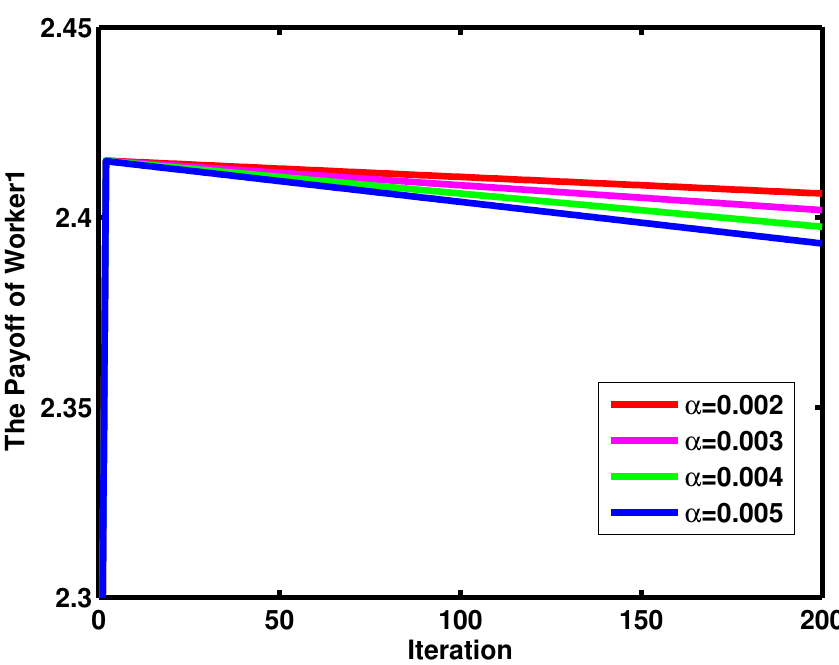
Figure 11. The payoff of worker 1 using ZD1 strategies with different α